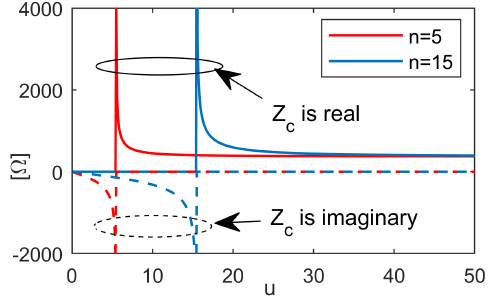
Figure 5. Characteristic impedance of TE nm mode for n = 5 and